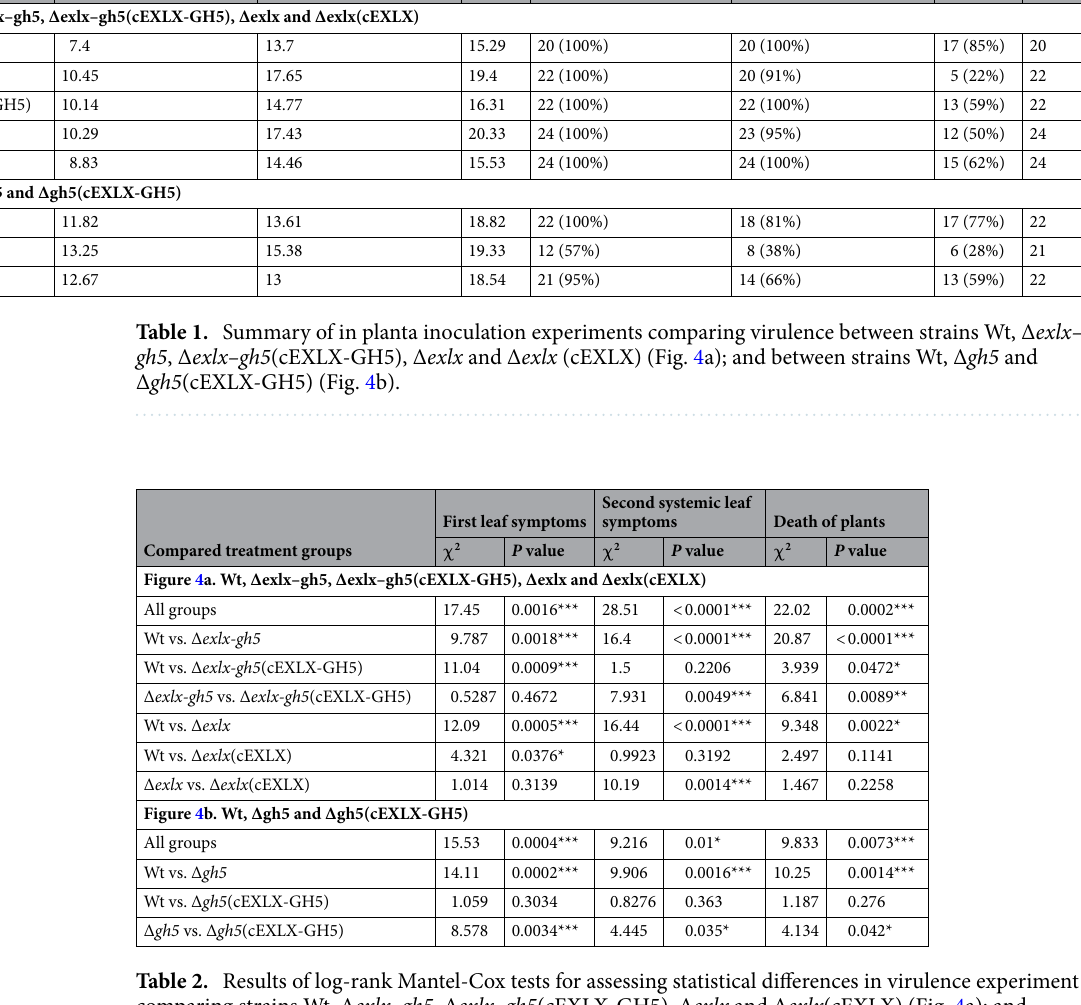
Figure 4a. Wt, Δexlx–gh5, Δexlx–gh5(cEXLX-GH5), Δexlx and Δexlx(cEXLX)